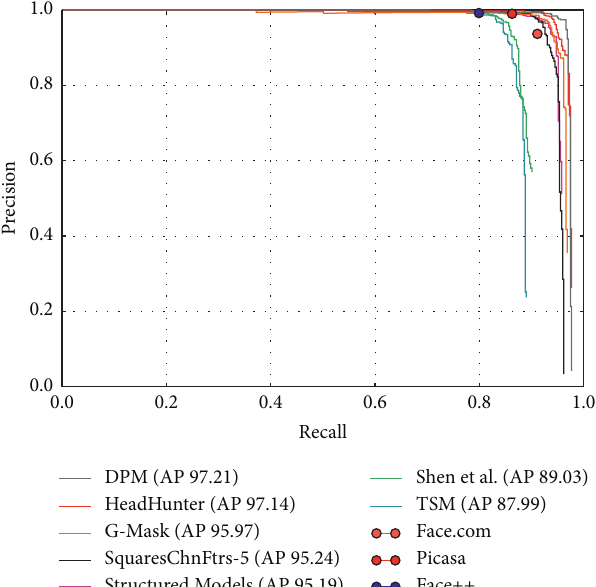
Figure 7: The precision-recall curve of our method on the AFW benchmark. Data of other models and evaluation code are derived from